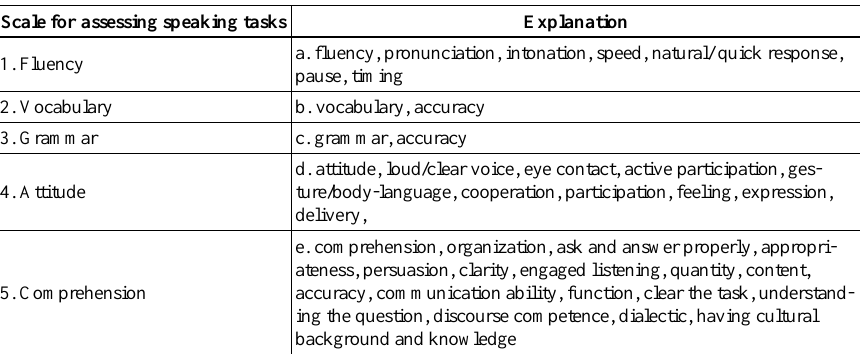
Table 1. The scale for assessing speaking tasks Scale for assessing speaking